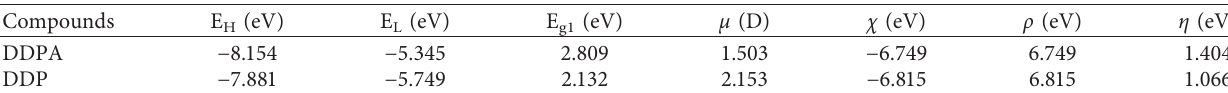
Figure 2: DDP and DDPA molecular modeling graphical presentation of HOMO (H)/LUMO (L) orbitals, H − 1/L +1, and H − 2/L +2 and the energy gap of H/L (E g1 ), H − 1/L +1 (E g2 ), and H − 2/L+2 (E g3 ) in the gas state via utilizing the B3LYP/6-31G (d) level of theory. Table 2: Calculated HOMO energy (E H ), LUMO energy (E L ), energy gap (E g1 ), dipole moment ( μ ), and other quantum parameters such as electronegativity ( χ ), chemical potential ( ρ ), and chemical hardness ( η ) of DDP and DDPA molecular structures in the gaseous state obtained and obeying the B3LYP/6-31G (d) level of